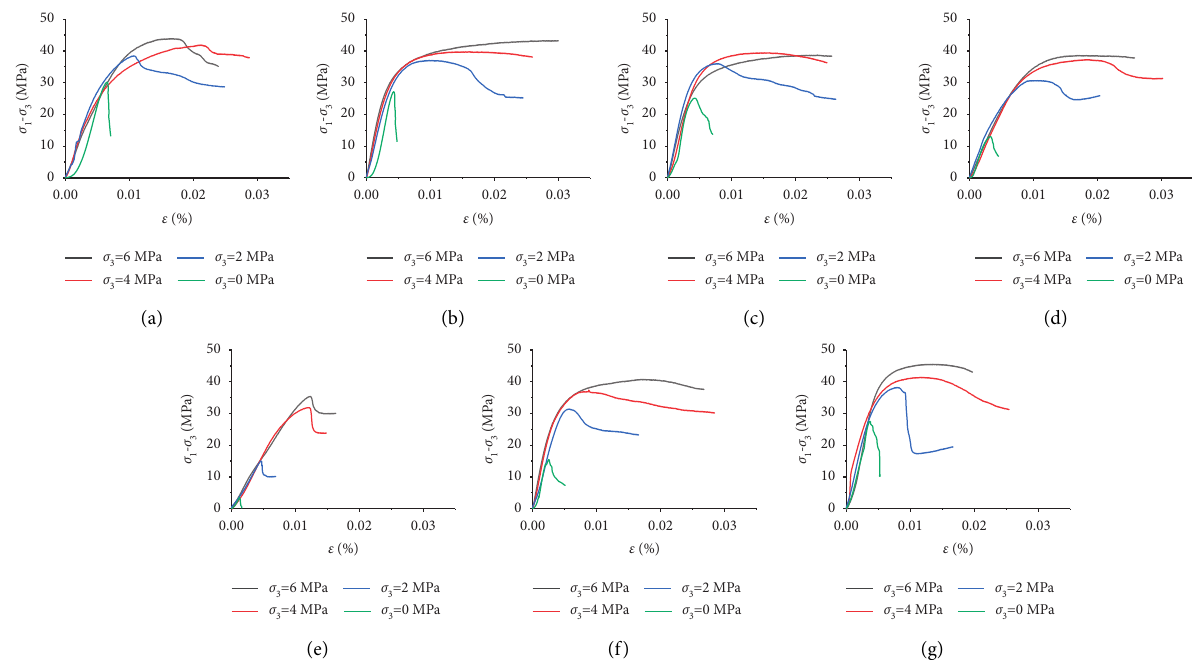
Figure 6: Stress-strain curves of Group AA layered composite rock under triaxial compression: (a) β � 0 ° , (b) β � 15 ° , (c) β � 30 ° , (d) β � 45 ° , (e) β � 60 ° , (f) β � 75 ° , and (g) β � 90 °